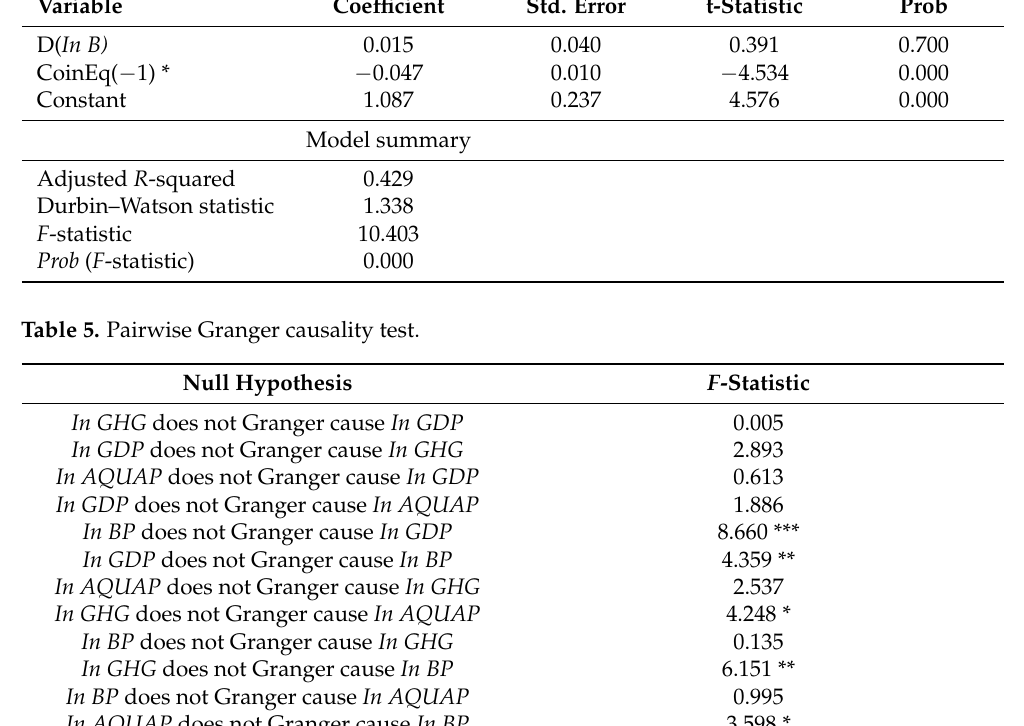
Table 6. Diagnostic tests .